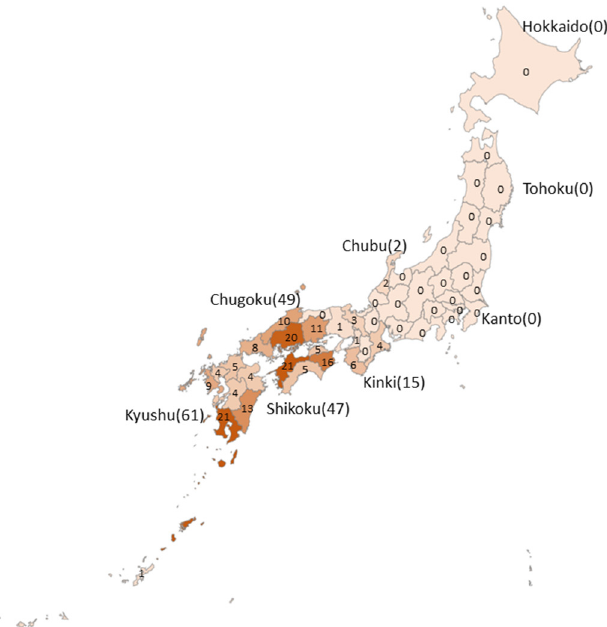
Figure 3. Geographic prevalence of the cases.